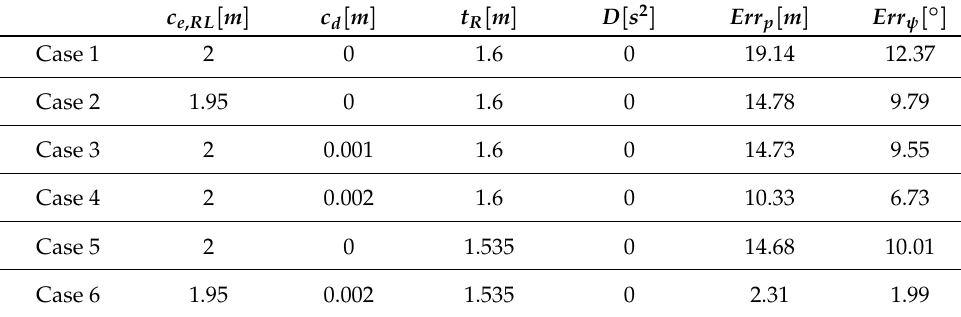
Figure 3. Path and wheel rotation signals of the motivation example. The presented odometry model is initialized at the start point with the measurements, and integrated using the wheel rotation measurements. The sideslip and dynamic wheel model is not utilized at this time. The two-wheel model is tested with various settings, which can be found in Table 1. The model settings are compared based on the mean position ( Err p ) and orientation ( Err ψ ) errors calculated from the reference ones. In Case 1, the nominal values are used that available in the vehicle data sheet. The nominal circum- ferences ( c e , i , nom = 2 m) are the geometry circumference of the wheel without load, and the rear left and right are assumed to be equal. Thus, these values are highly uncertain and result in an enormous 19 m mean position and 12 ◦ mean orientation error. Table 1. Parameters and errors of the motivation example cases